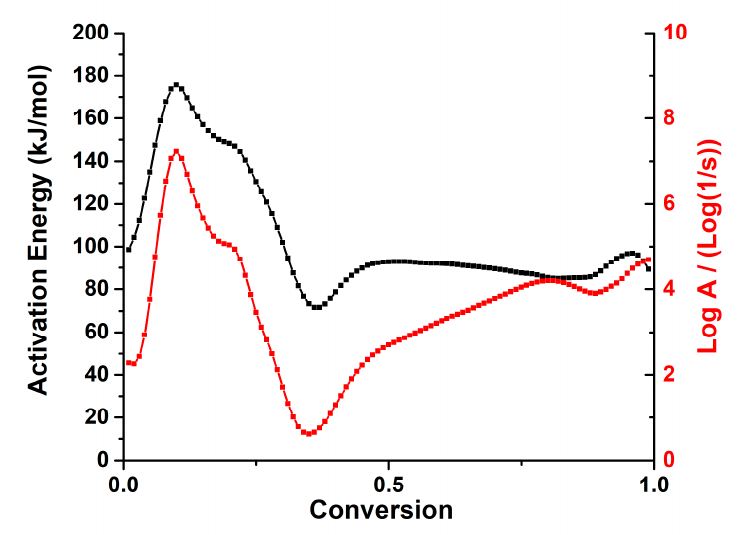
Figure 15. Activation energy (black) and pre-exponential factor (red) plot for PEEK in air, obtained by Friedman analysis.